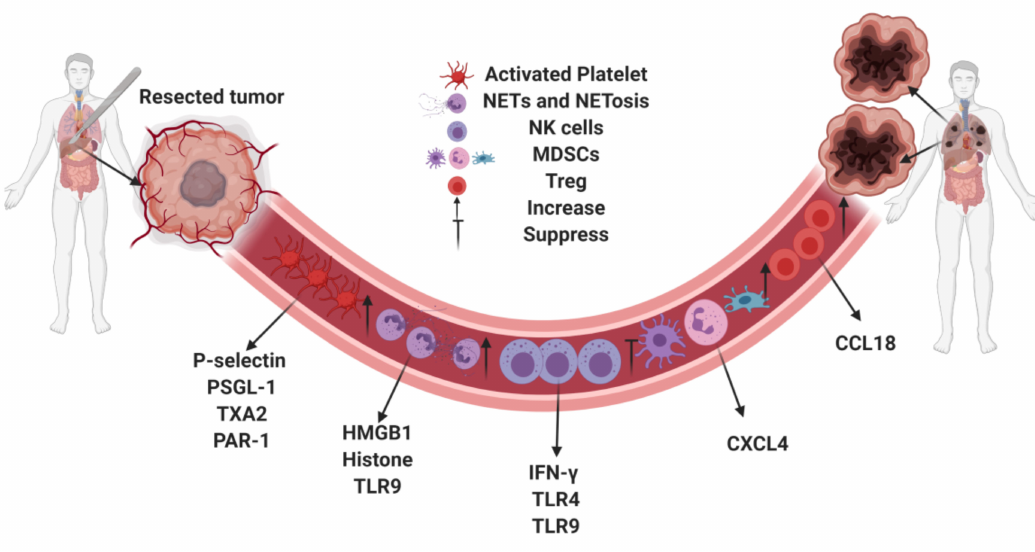
Figure 1. Surgical stress promotes tumor metastasis by regulating the innate and adaptive immune systems via